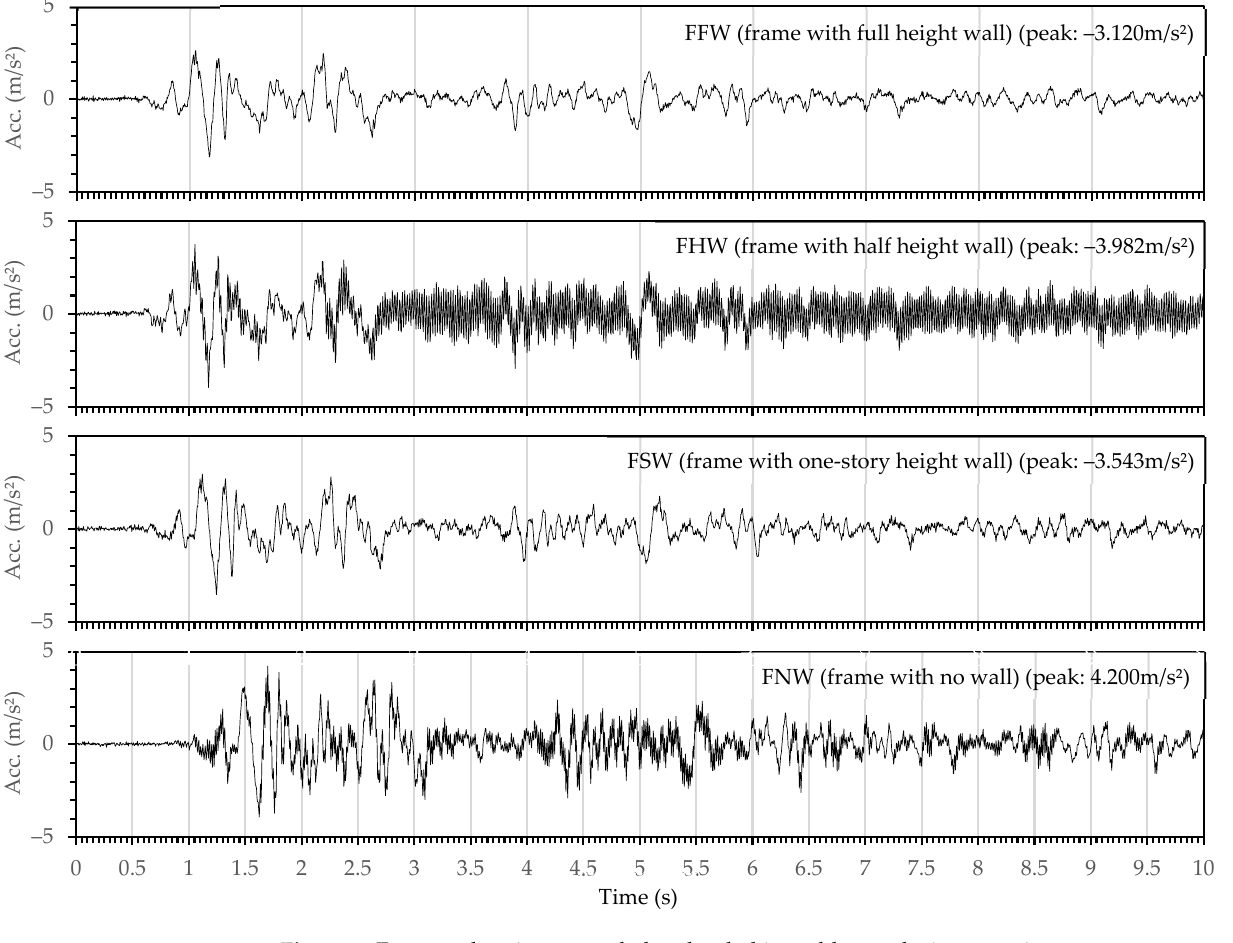
Figure 4. Four accelerations recorded at the shaking table test during experiments.